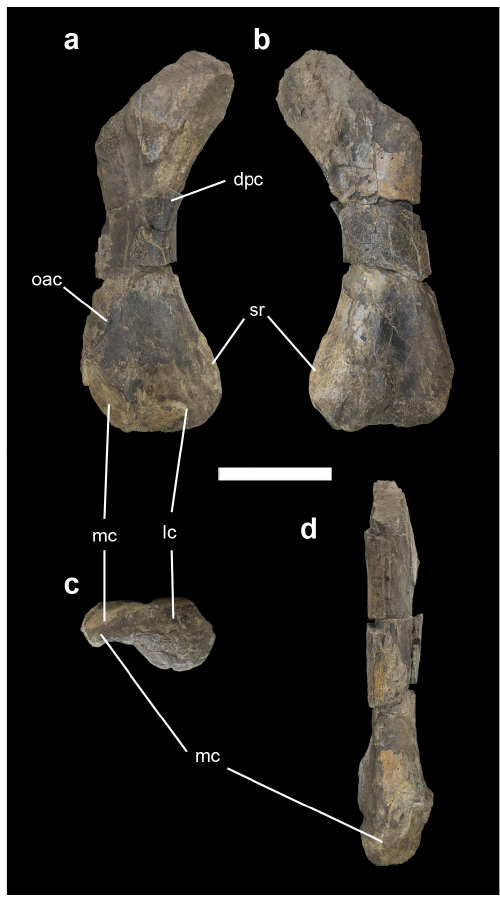
Figure 2. CT-61-1. Left humerus from CT-61 fossil site (El Castellar, Teruel, Spain) in anterior ( a ), posterior ( b ), distal ( c ) and medial ( d ) views. Abbreviations: dpc: deltopectoral crest; lc: lateral (ra- dial) condyle; mc: medial (ulnar) condyle; oac: oblique anterior crest; sr: supinator ridge. Scale bar = 20 cm.